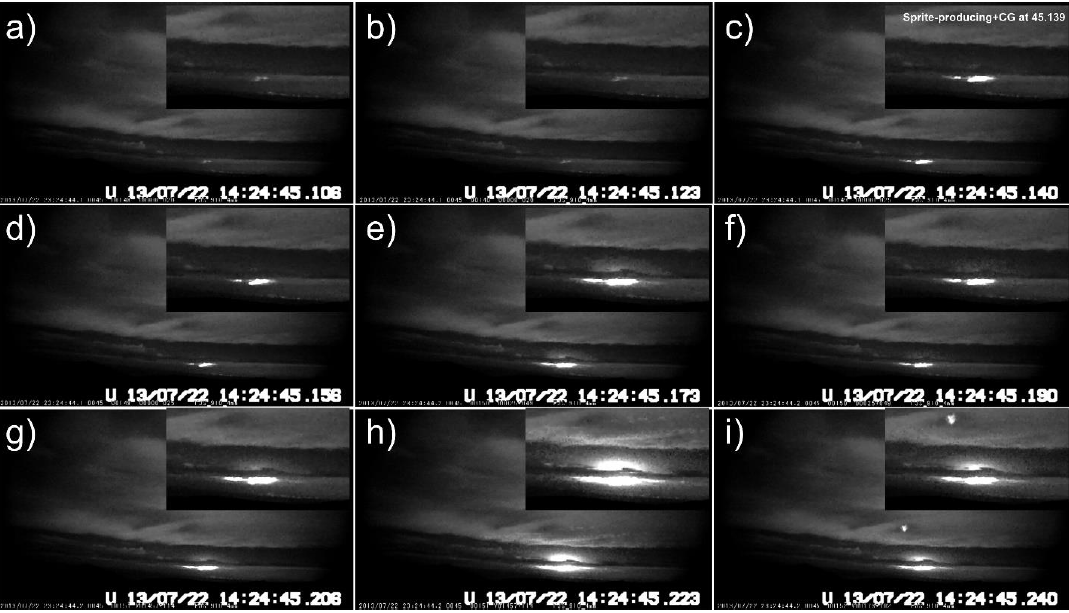
Figure 12. Time series of optical cloud flash associated with sixth sprite and enlarged images every 16.7 ms ( a – i